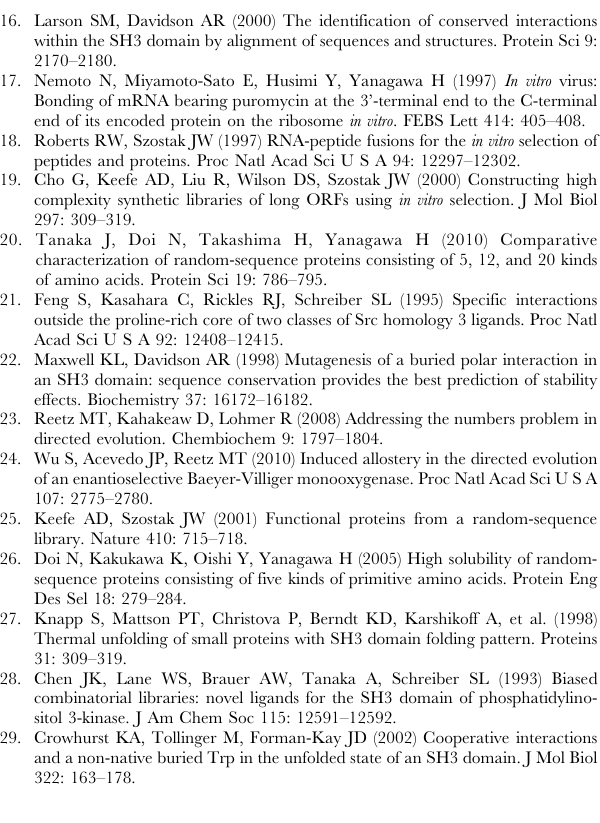
Table S1 Percentage of each amino acid in the random- ized region of the initial and third rounds of libraries. Table S2 Oligonucleotide sequences used in this study.